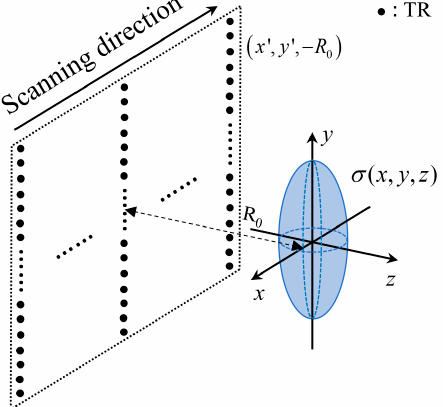
Figure 1. MMW imaging scheme by a linear array with mechanical scanning.